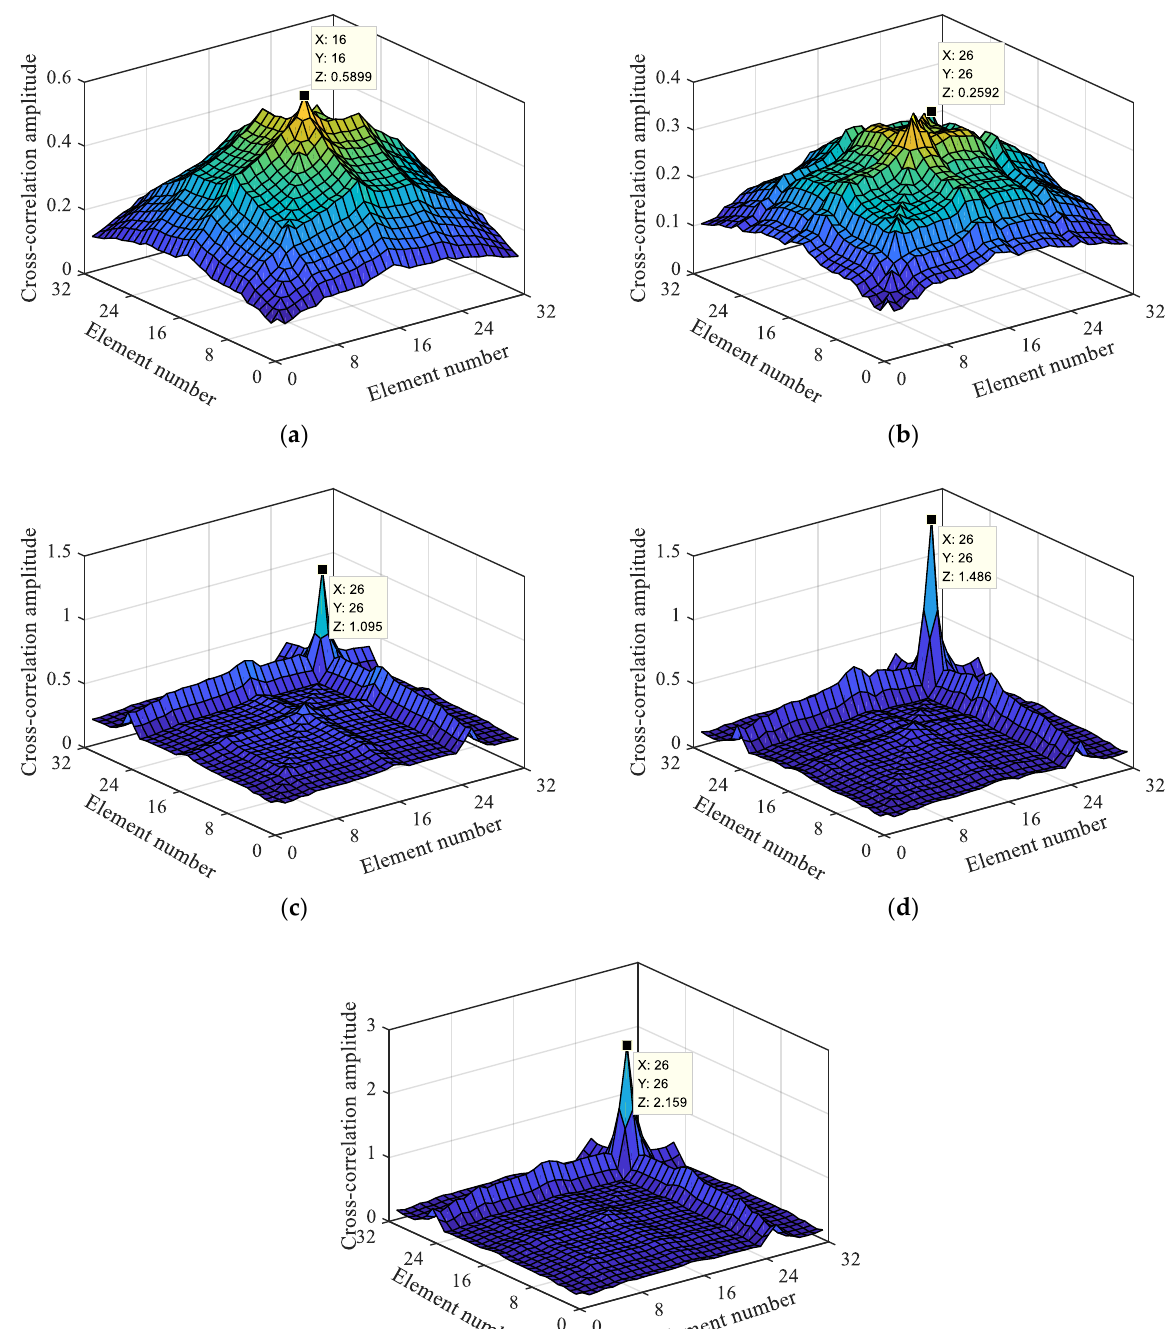
Figure 12. Macro-dynamic strain cross-correlation based on a single damage location with different damage levels; ( a ) Non-destructive; ( b ) Level 1; ( c ) Level 2; ( d ) Level 3; ( e ) Level 4.